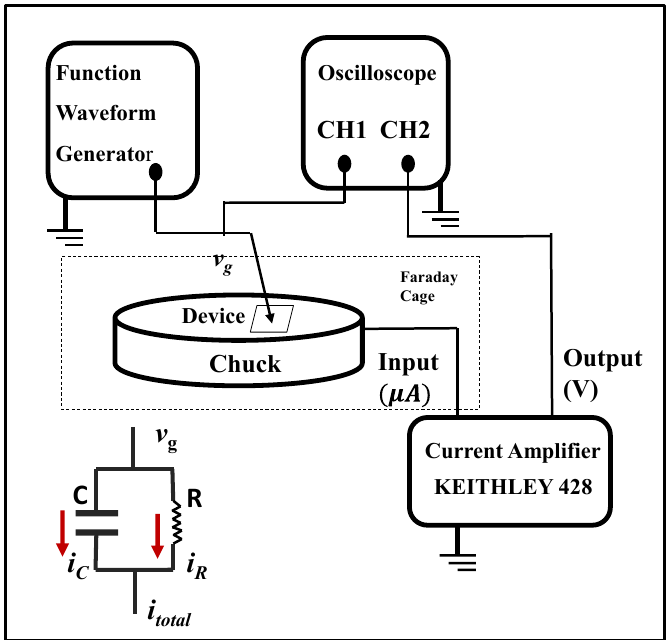
Figure 1. Pulse capacitance-voltage (CV) measurement system structure